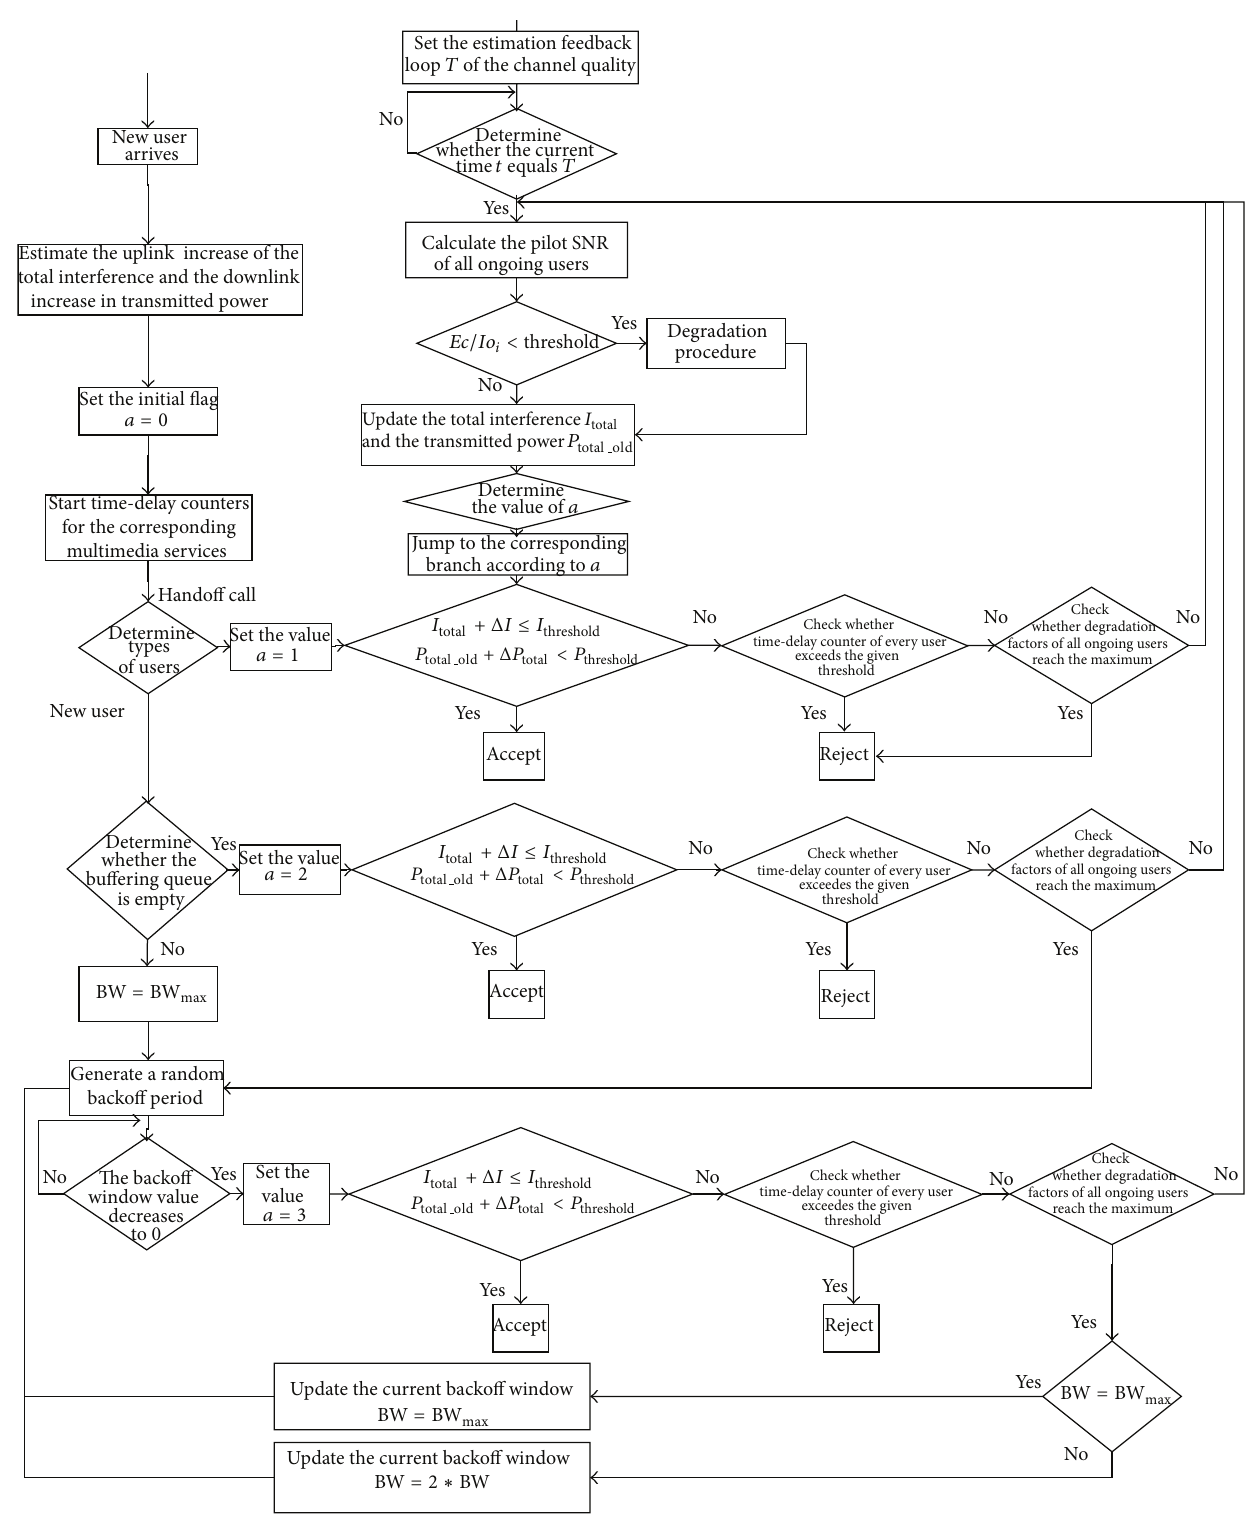
Figure 11: Flowchart of the proposed CAC